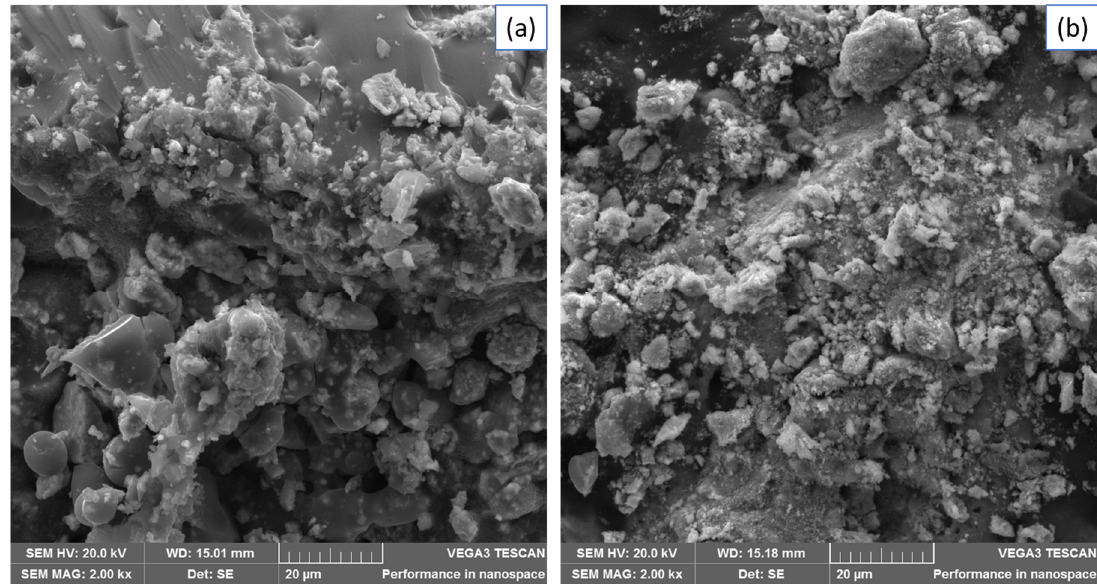
Figure 9. SEM micrographs of Fe 3 O 4 -ZrO 2 @APS ( a ) before and ( b ) after adsorption.